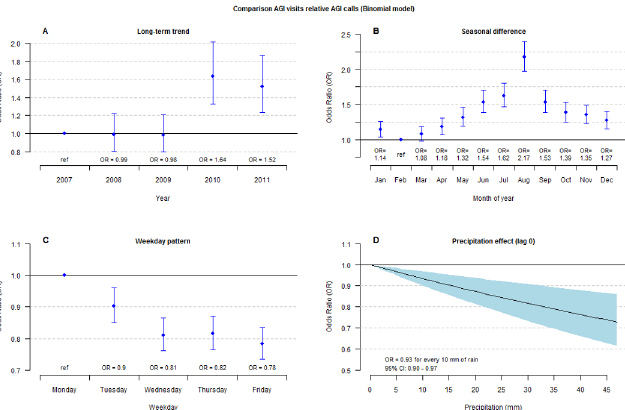
Fig 1. AGI visits relative AGI calls. Comparison of AGI visits relative AGI calls using a binomial regression model including all data (City of Gothenburg). A. Long term trend — estimated odds ratios by year. B. Seasonal difference — estimated odds ratios for month of year. C. Week day effect — estimated odds ratios for weekdays. D. Estimated odds ratio of precipitation lag 0. Bars and filled area represent 95% confidence